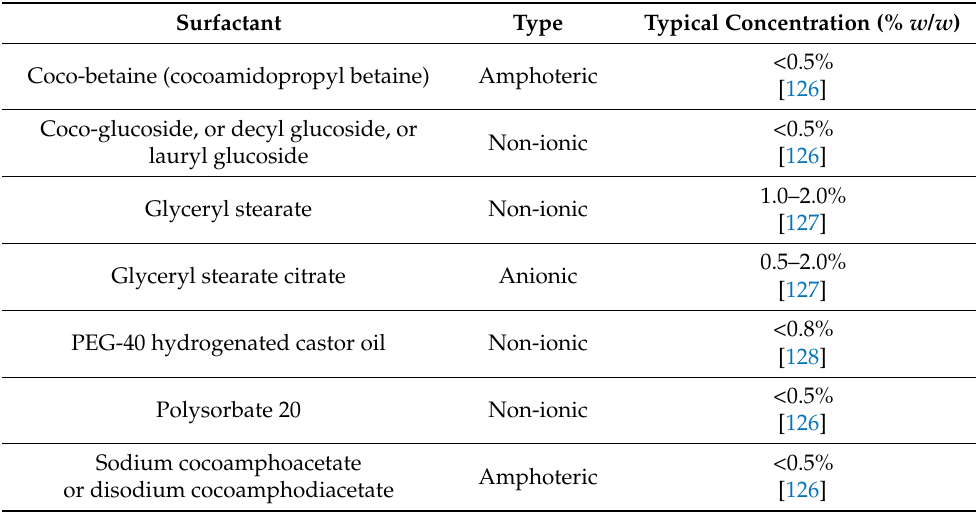
Table 7. Common surfactants used in baby wipe formulations. Surfactant Type Typical Concentration (% w / w ) Coco-betaine (cocoamidopropyl